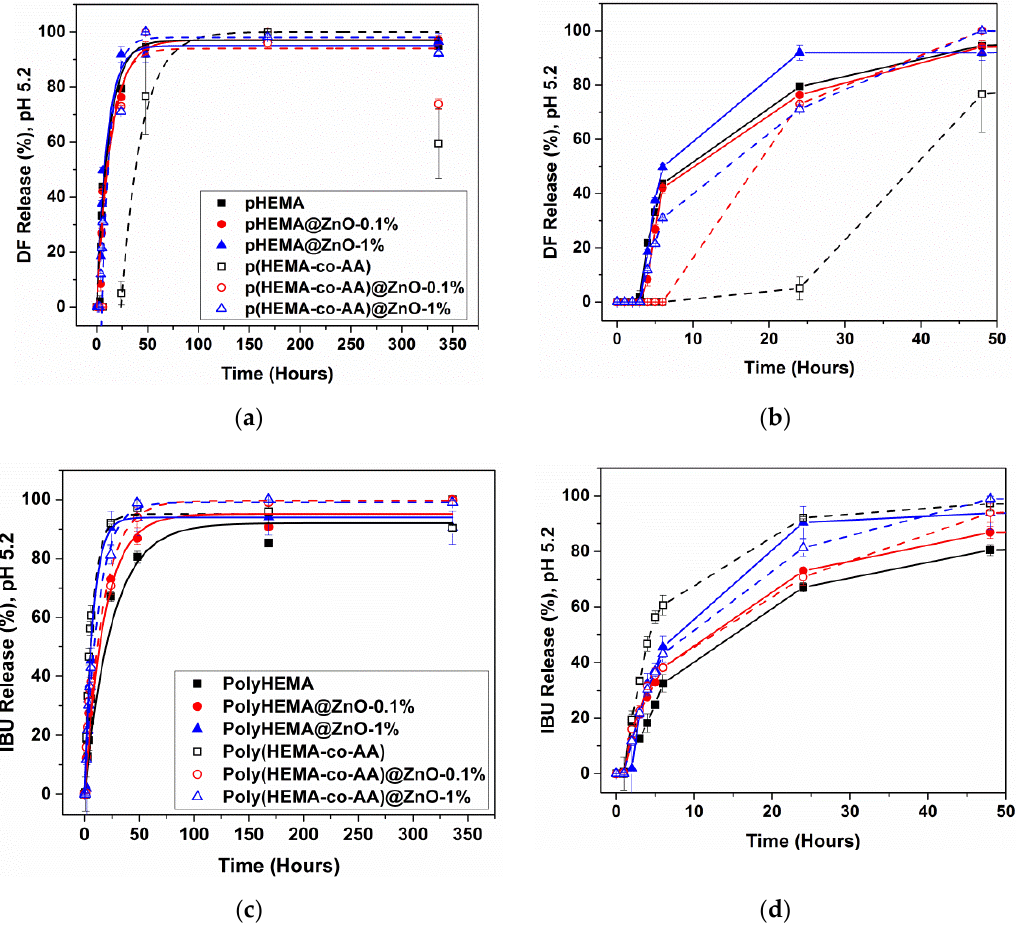
Figure 9. Drug release profiles during time in acidic artificial urine solution: ( a , b ) diclofenac and ( c , d ) ibuprofen, both in sodium salts form. Experimental points are reported along with their error bars. All of the experimental points follow a pseudofirst-order kinetic law. Fitting curves are represented by plain lines for pHEMA-based samples and by dashed lines for p(HEMA-co-AA)-based samples. Table 2. Kinetic parameters for DF and IBU drug release at acidic pH